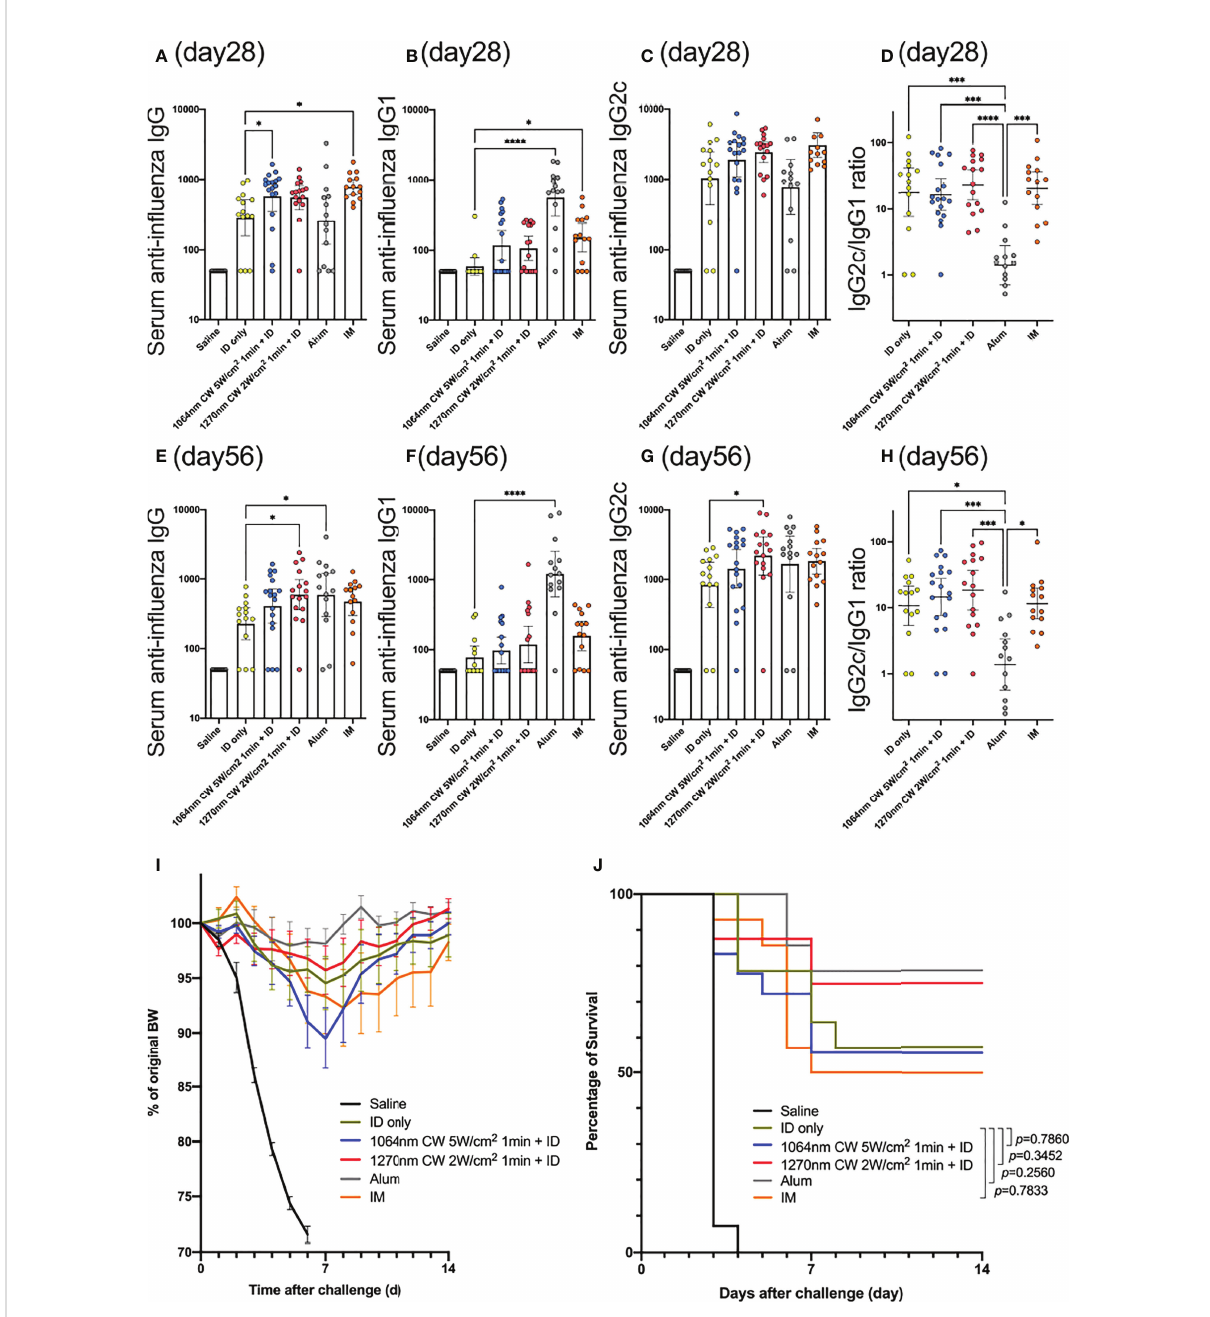
FIGURE 7 Effect of the near-infrared (NIR) laser adjuvant on anti-in fl uenza immune responses. Serum anti-in fl uenza speci fi c (A) IgG, (B) IgG1, (C) IgG2c, (D) IgG2c/IgG1 ratio at day 21, and (E) IgG, (F) IgG1, (G) IgG2c, (H) IgG2c/IgG1 ratio at day 56. (A – H) n = 14, 14, 18, 16, 14, and 14 for no vaccine (saline), vaccine ID only (ID only), 1064 nm CW laser + vaccine ID, 1270 nm CW laser + vaccine, vaccine/alum ID (Alum), and vaccine IM, respectively. Results were pooled from three independent experiments and analyzed using the Kruskal – Wallis test followed by the Dunn ’ s multiple comparison test. (* p <0.05, *** p <0.001, **** p <0.0001 compared with ID only) Geometric mean with 95% CI. (I) The effect of the NIR laser adjuvant on body weight of vaccinated mice following viral challenge. Body weights were monitored daily for 2 weeks. Mean body weight ± s.e.m. n = 14, 14, 18, 16, 14, and 14 for no vaccine (saline), vaccine ID only (ID only), 1064 nm CW laser + vaccine ID, 1270 nm CW laser + vaccine, vaccine/alum ID (Alum), and vaccine IM, respectively. (J) Kaplan – Meier survival plots for 2 weeks following lethal in fl uenza challenge; Gehan – Breslow – Wilcoxon test. (I, J) Results were pooled from three independent